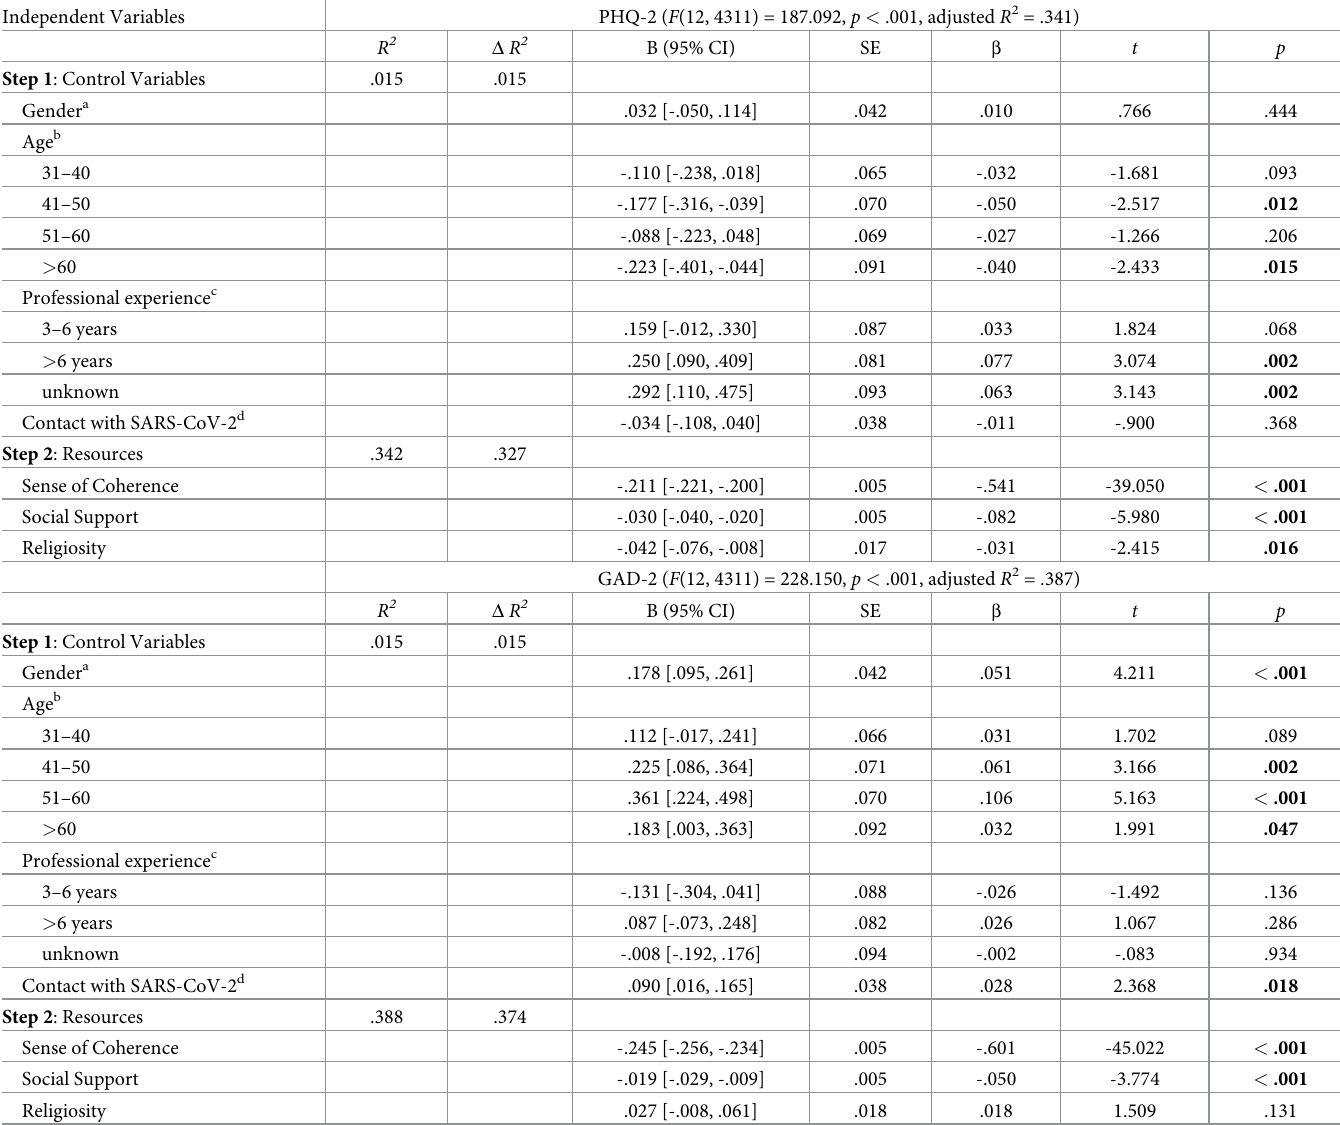
Table 4. Regression analyses for depressive (PHQ-2) and anxiety symptoms (GAD-2). Independent